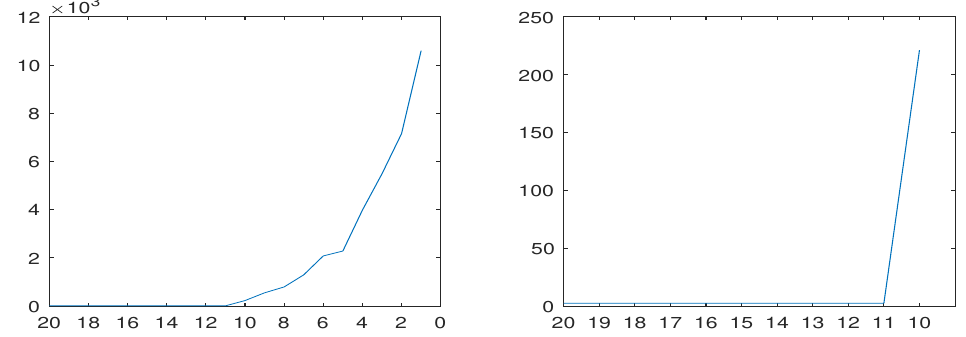
Figure 8: Left side: | λ 20 ( A n ) | < ··· < | λ 1 ( A n ) | ; right side: | λ 20 ( A n ) | < ··· < | λ 10 ( A n ) | in a typical realization in case (c) of Example